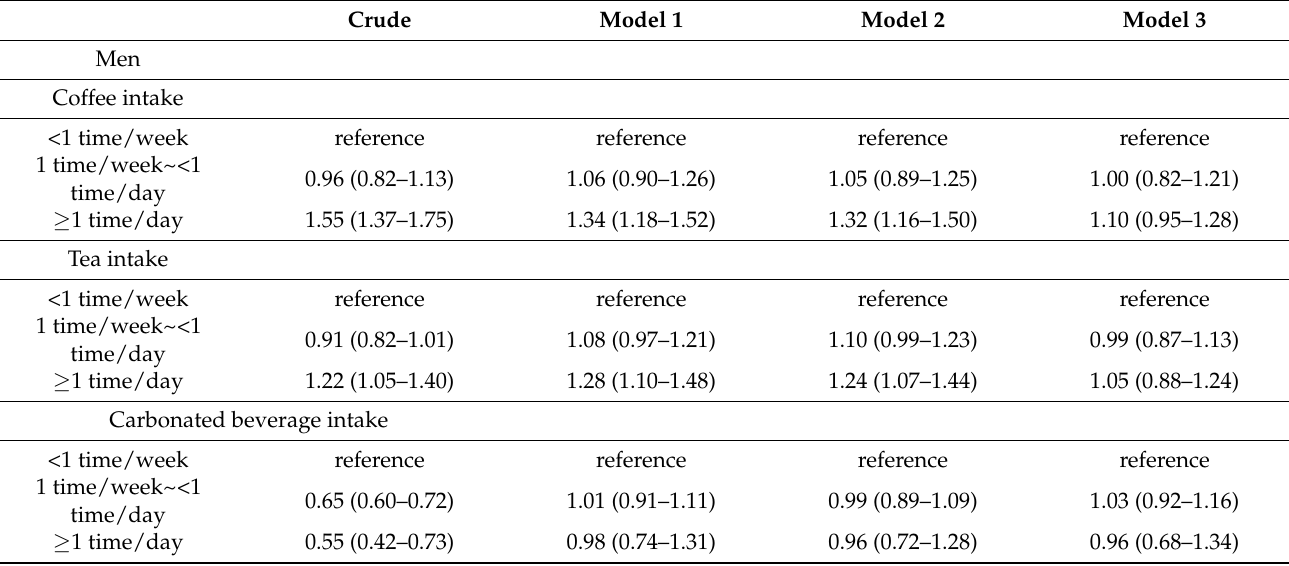
Table 4. Multivariable logistic regression for metabolic syndrome according to the frequency of intake of coffee, tea, and carbonated